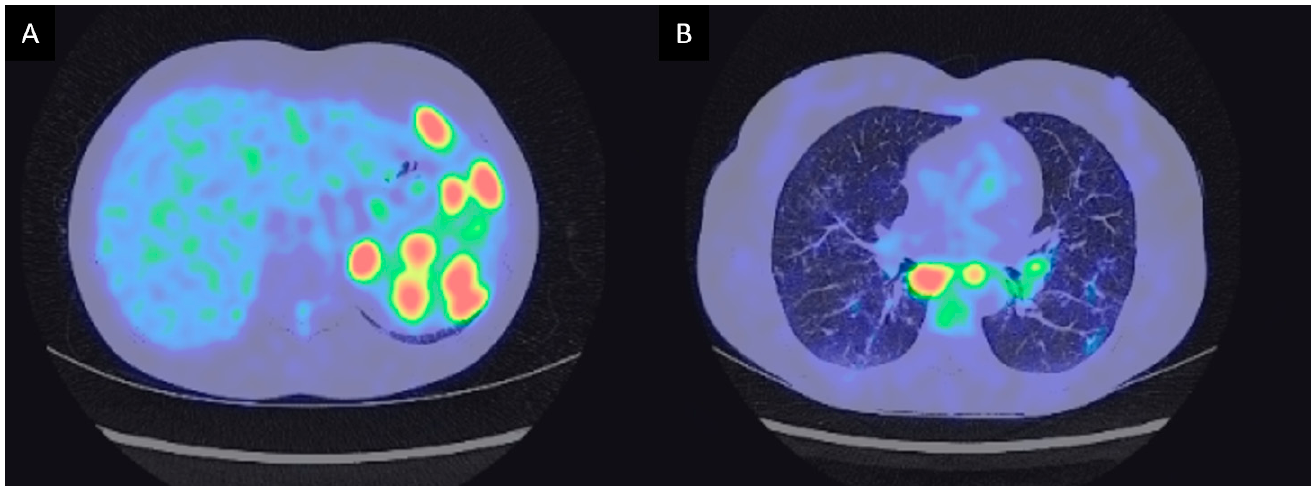
Figure 1. Axial abdominal MRI slices showing hyperintense splenic nodules on T2-weighted sequence ( A ) and hypointense signal on the early gadolinium-enhanced T1 acquisition ( B ).